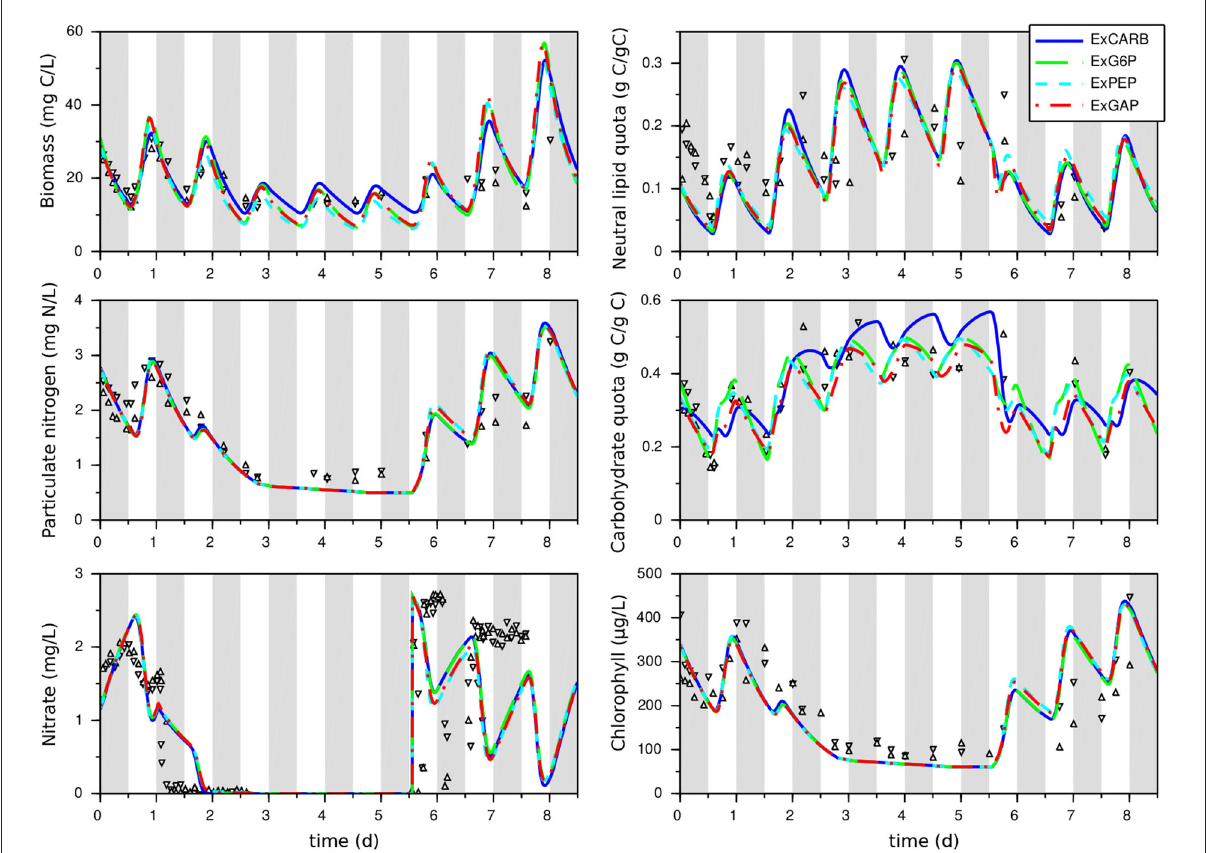
FIGURE3 Calibration of the models that take into account excretion with a T. lutea culture under day/night cycles and nitrogen starvation. Experimental data taken from Lacour et al. (2012a) are represented by symbols. Gray bands represent night periods.